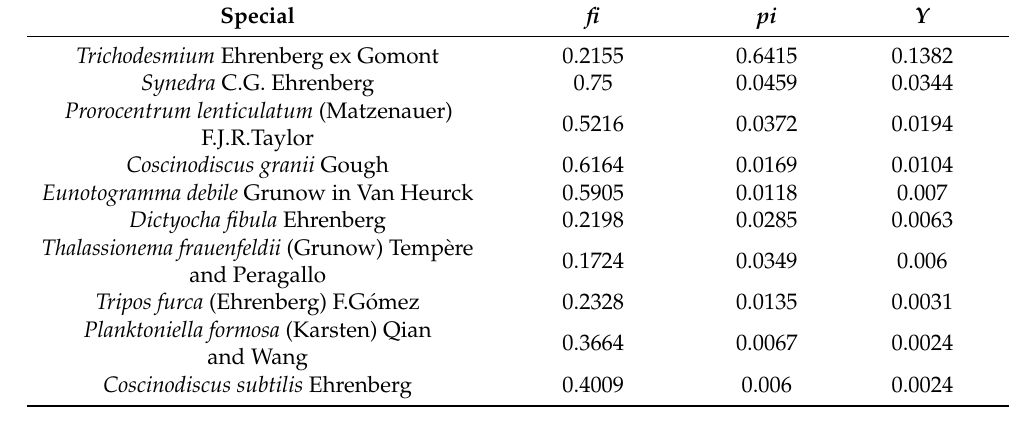
Table 1. Dominant phytoplankton species in the BOB.